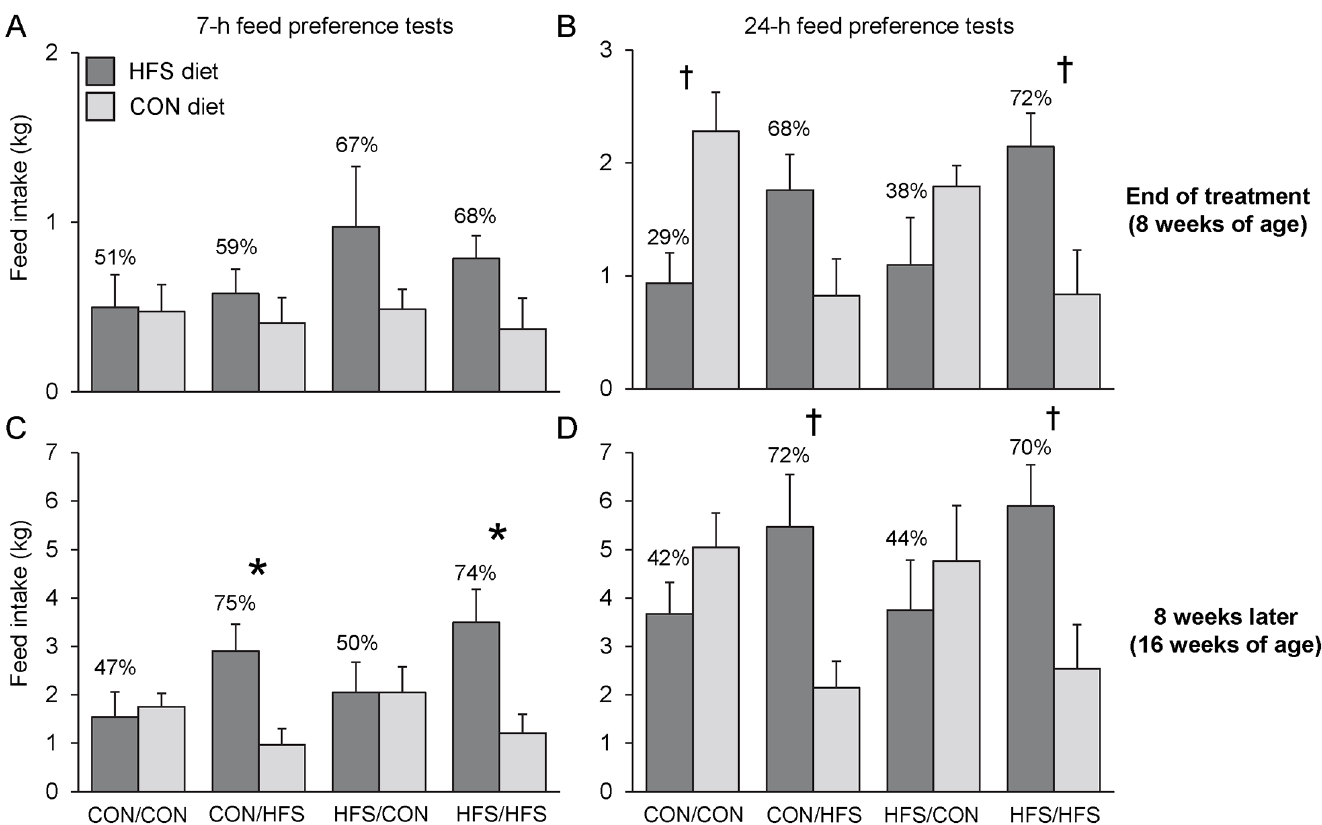
Fig 3. Feed intake (kg) during the feed preference tests. (A) 7 ‒ h and (B) 24 ‒ h feed preference tests done at the end of the dietary treatment, and (C) 7 ‒ h and (D) 24 ‒ h feed preference tests done 8 weeks later. During the tests, the piglets had the choice between the HFS diet and the control (CON) starter diet distributed in two feeders in the home pen. Percentages above bars indicate the intake of the HFS diet relative to total intake during the test. Symbols indicate significant differences between the absolute intake of the HFS vs . CON diet during the test: * p (cid:1) 0.05; † 0.05 < p (cid:1) 0.10.